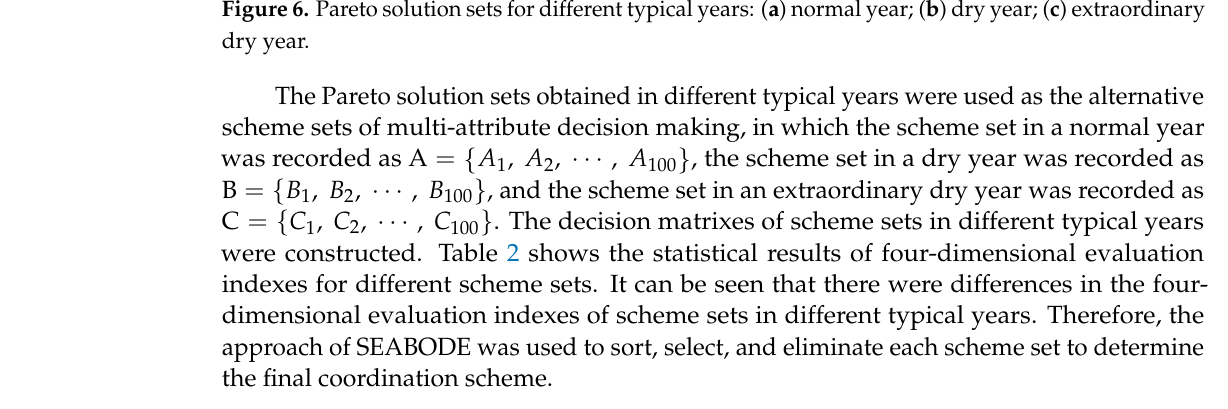
Table 2. Statistical results of 4-dimensional evaluation indexes for different scheme